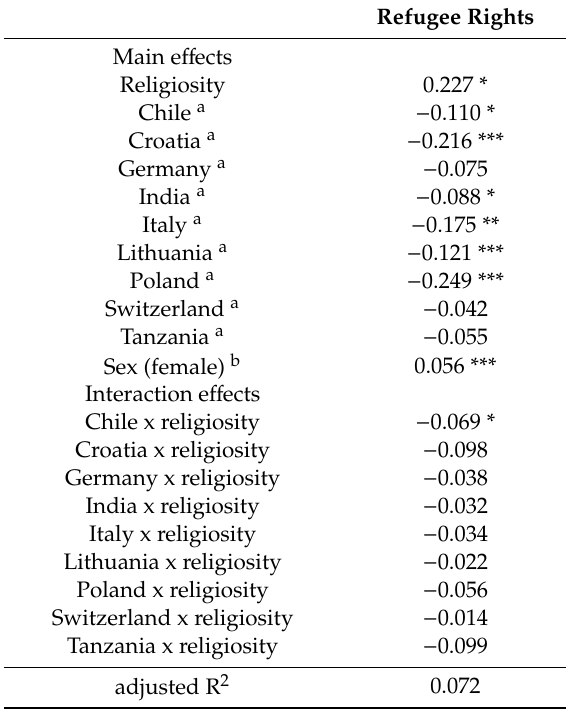
Table 4. The influence of religiosity, country, sex, and the interaction between religiosity and country on attitudes towards refugee rights (OLS